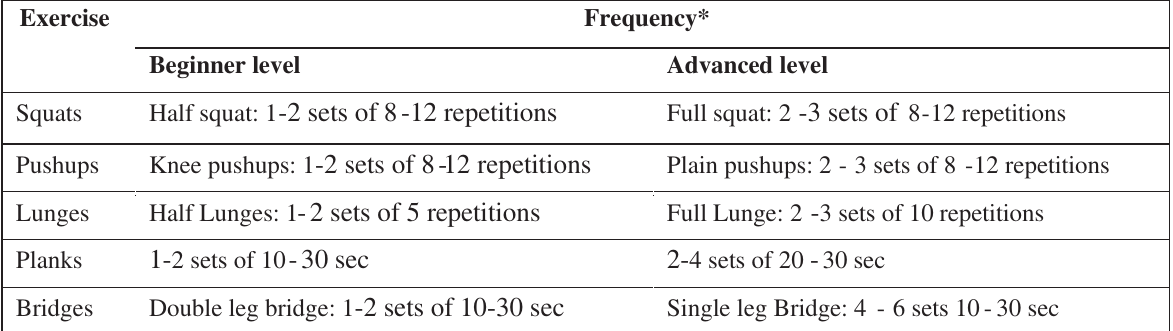
Table 2: Home based muscle and bone strengthening exercises for beginners and advanced